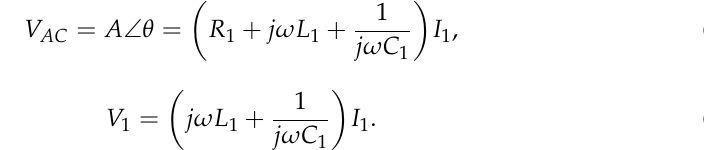
Figure 2. Equivalent metal object detection circuit.